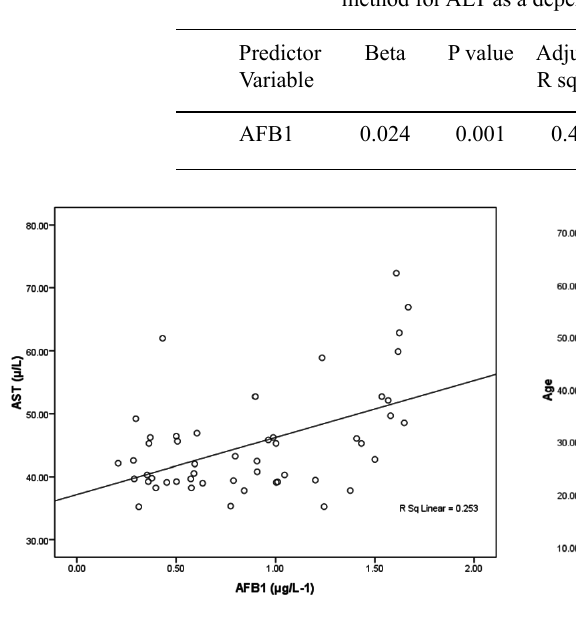
table 4. Multiple regression using